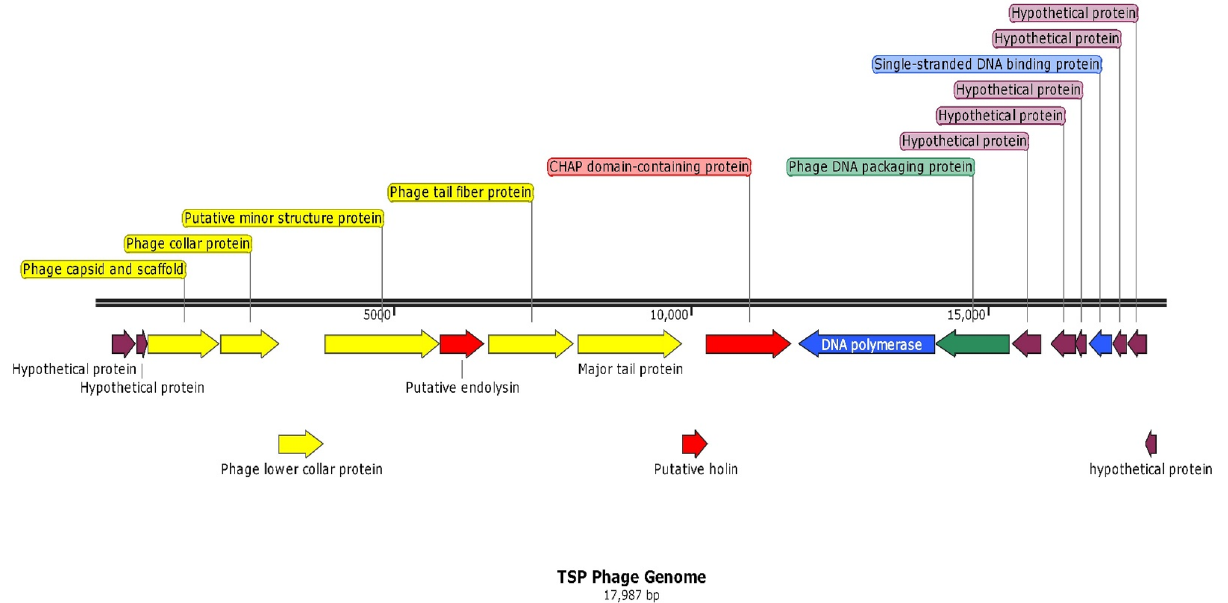
Figure 6. Linear genome map of TSP phage. The direction of ORFs is depicted via arrows. Four functional groups are present in the TSP phage genome, and genes in each functional group are represented by different colors: structural genes (yellow), regulatorygenes (blue), host lysis genes (red), and DNApackaginggenes (green). Hypothetical ORFs are indicated in